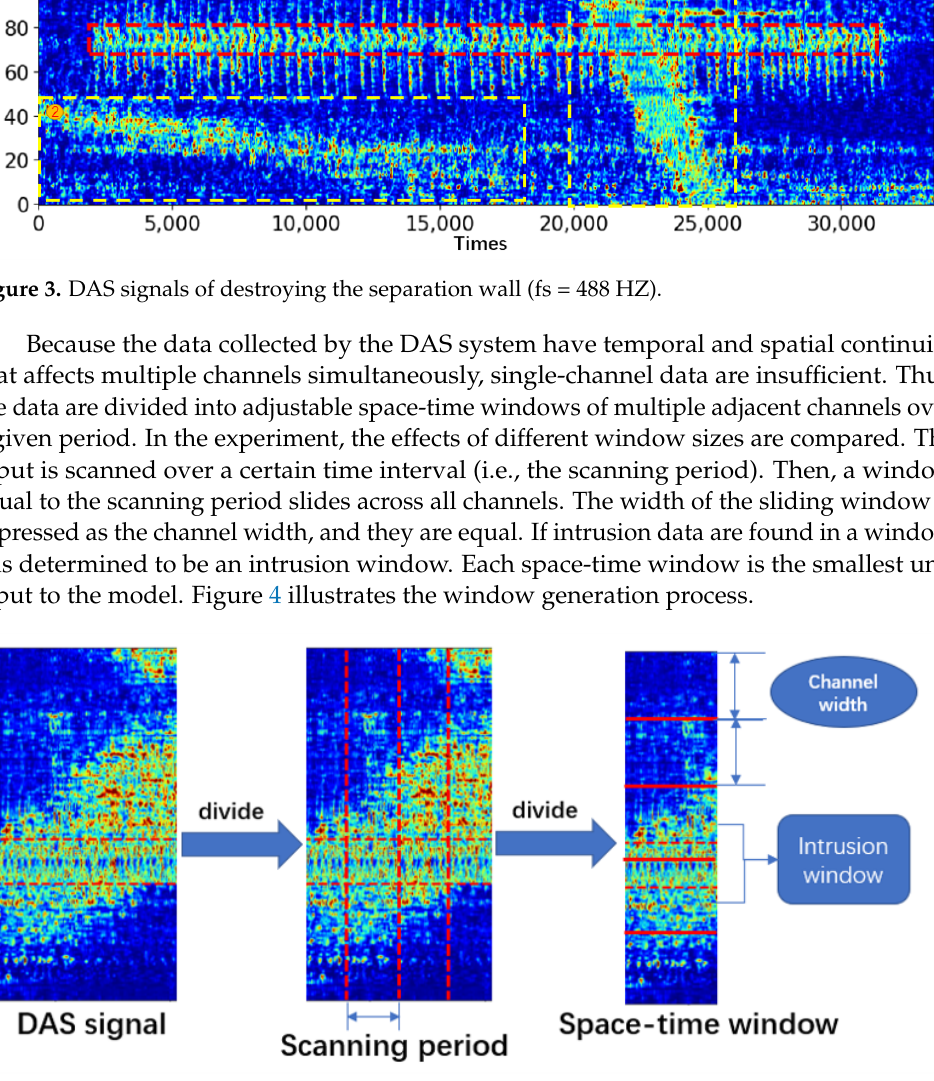
Figure 4. Generate space-time